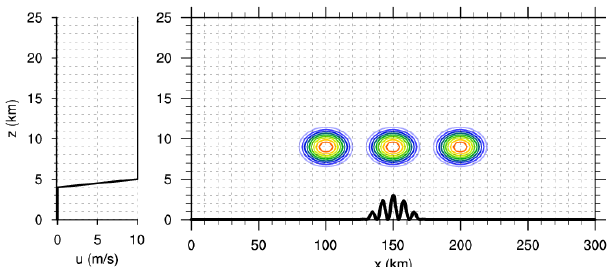
Figure 6. The wind field, the analytical solution of tracer and moun- tain used in the 2-D linear advection experiments. The left panel is the vertical profile of the analytical solution of the given u field. The coloured contours in the right panel represent the tracer q with the contour interval of 0.1, and the thick black curve, the wavelike